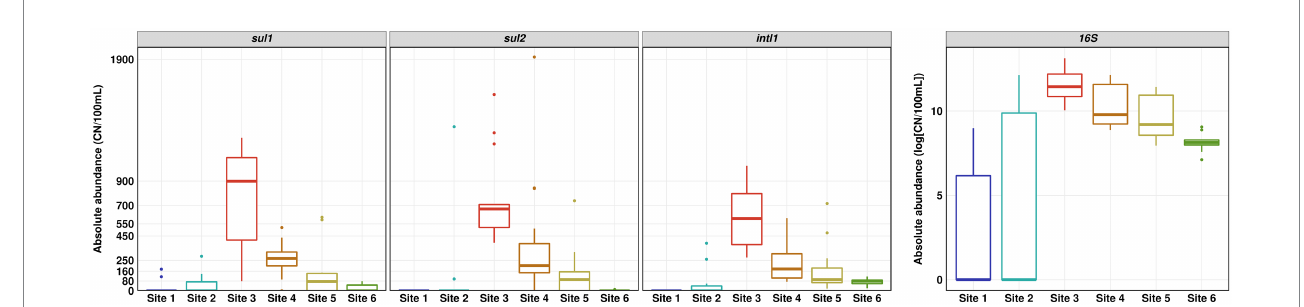
FIGURE 4 Absolute abundance of sul1 , sul2 , intI1 and 16S rRNA gene determined by quantitative real-time PCR. Number of replicates ( n ) = 15.